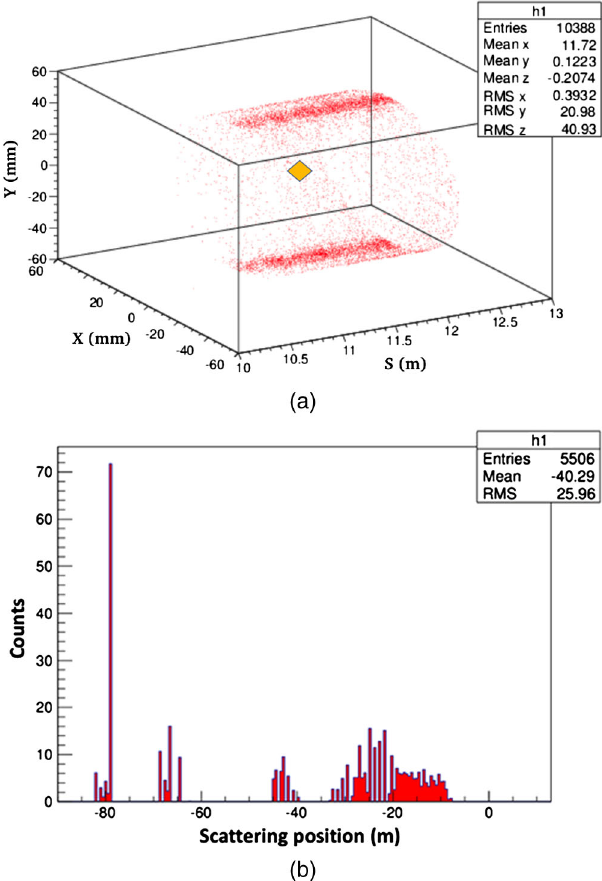
FIG. 11. (a) 3D distribution of the positions of the charged secondaries exiting the 6 mm Cu cylinder beam pipe with the yellow diamond representing our DS (b) the scattering positions of the Coulomb positrons lost in the DS in the drift (from simulation).